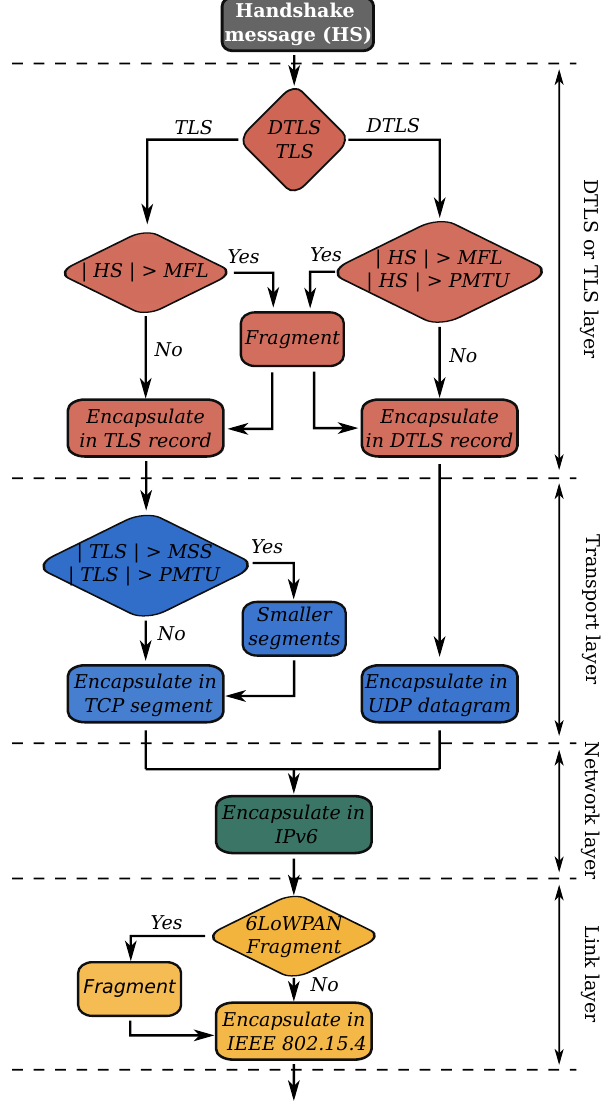
Figure 9. The different layers on which fragmentation occurs before a handshake message is sent by the IEEE802.15.4